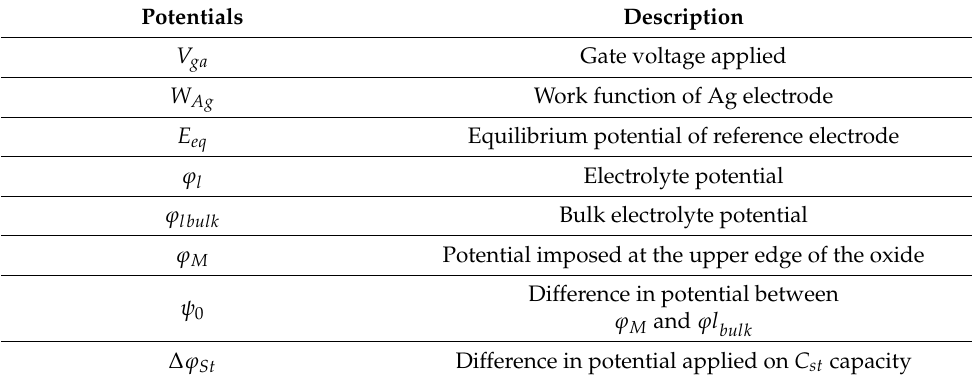
Figure 3. Potential diagram of ISFET along the vertical axis in the electrolyte domain. Table 1. Description of the potentials involved in the